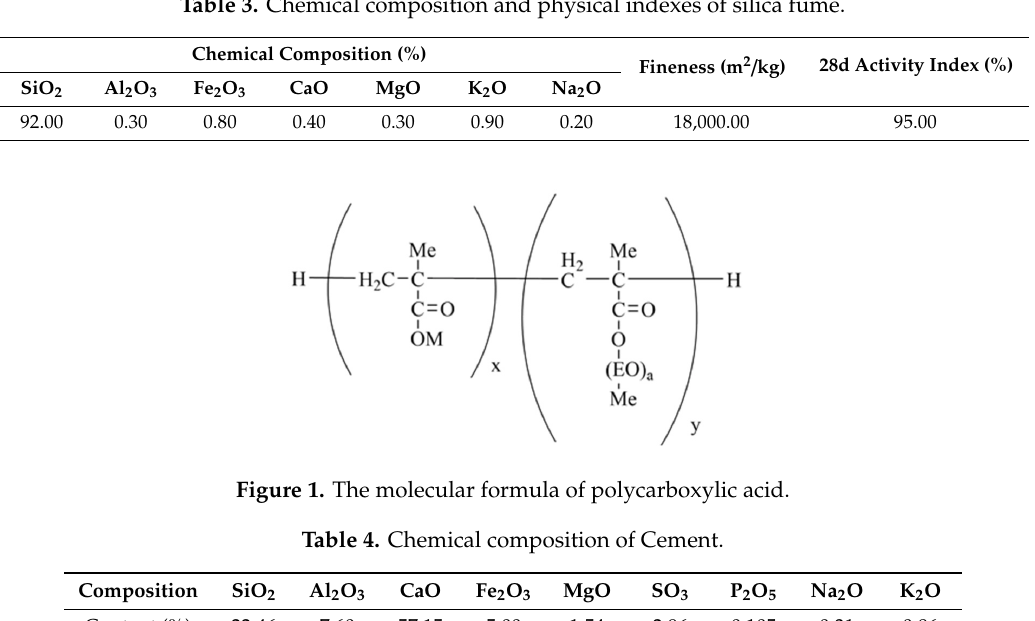
Table 5. Chemical composition and physical indexes of silica fume.